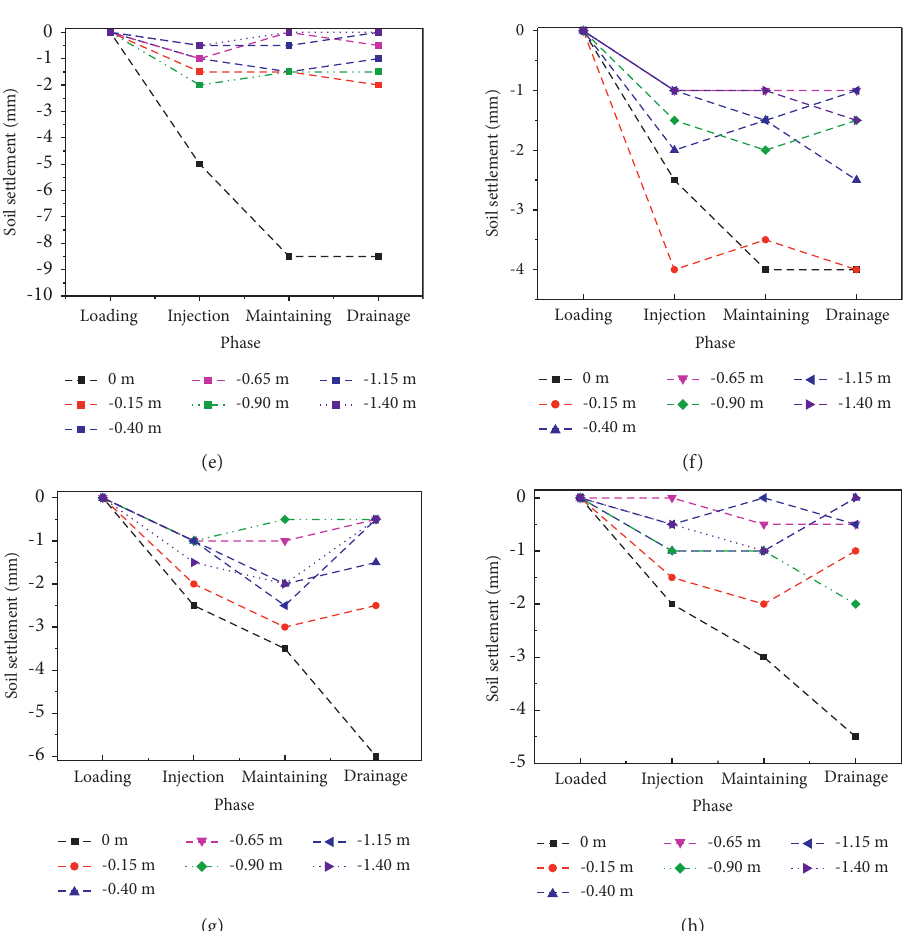
Figure 12: Settlement of layered soil versus time. (a) Point 1 (12kN). (b) Point 2 (12kN). (c) Point 3 (12kN). (d) Point 4 (12 kN). (e) Point 1 (24kN). (f) Point 2 (24 kN). (g) Point 3 (24 kN). (h) Point 4 (24